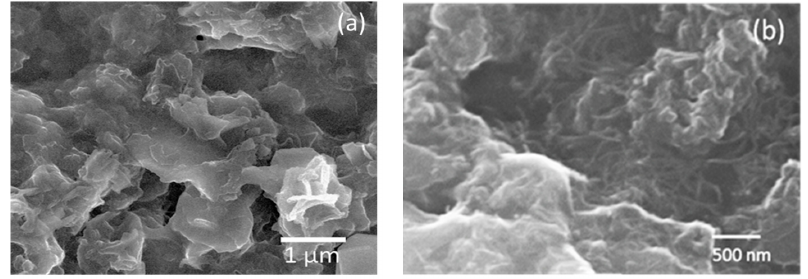
Figure 2. SEM image of ( a ) untreated ICPM and ( b ) argon plasma-treated ICPM metacomposite. Figure 3 shows the I-V characteristics at room temperature (24 °C) of the ICPM metacomposite before and after the argon plasma treatment. Measurements were taken separately in ambient air with approximately 55% RH, in the vacuum, and in the presence of H 2 gas at a pressure of 1 atm.